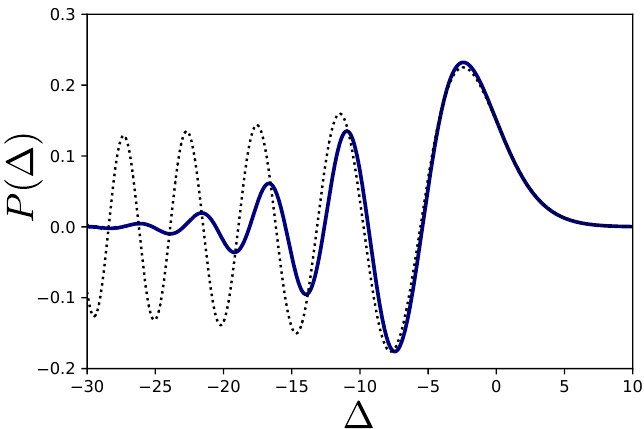
Figure 3: Distribution for the difference of work and heat ∆ = w − q . Having a vanishing mean and variance, this distribution is bound to have negative values if probabilistic violations of the first law are present (i.e., if it is not equal to a Dirac delta). The dotted line shows the Airy function in Eq. (66), exhibiting good agree- ment with P ( ∆ ) for small values of ∆ . Parameters: n h